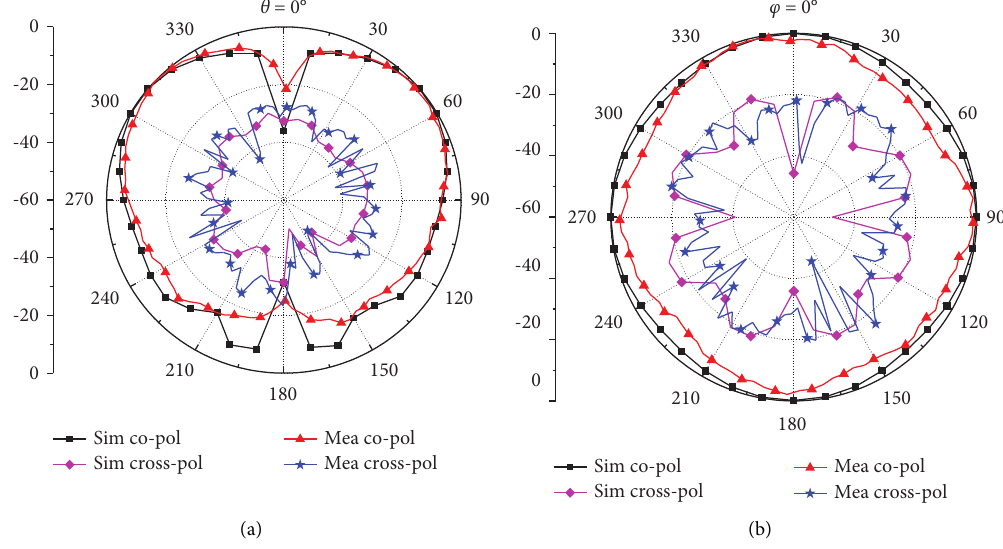
Figure 13: Simulated and measured radiation patterns at 6.2GHz. (a) φ � 0 ° ( x - z plane). (b) θ � 50 ° .